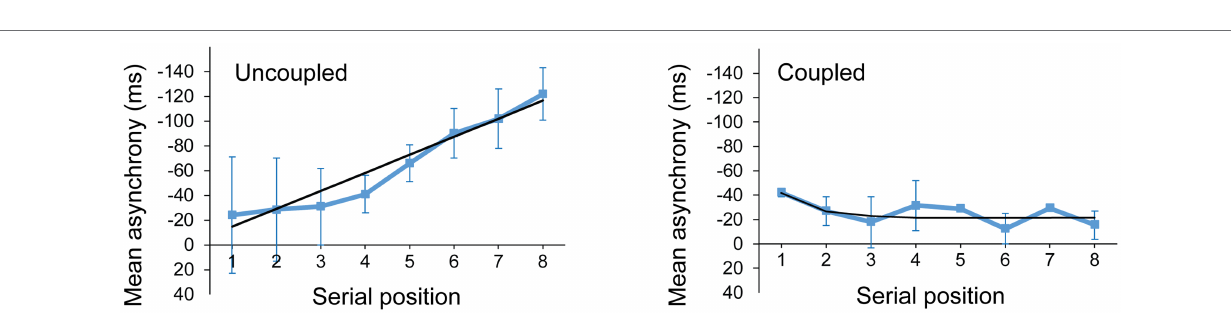
FIGURE 5 | Asynchronies predicted by the mixed model: Interaction between Slower/Faster Cued Rate and the absolute difference between the tapper’s SPR and the rate of the metronome. Zero on the x-axis represents the condition in which the metronome is cued at the tapper’s own rate.